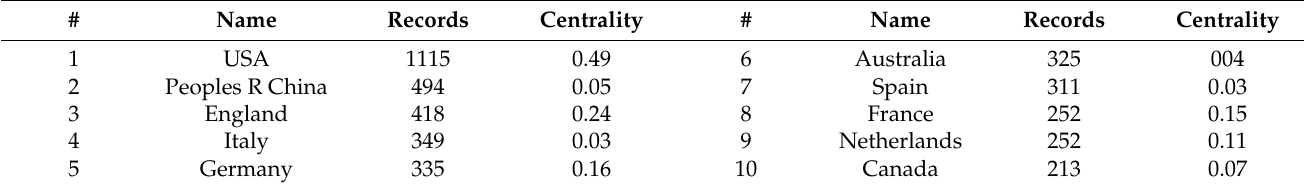
Table 4. Top 10 productive countries or regions during the period from 1990 to 2021.